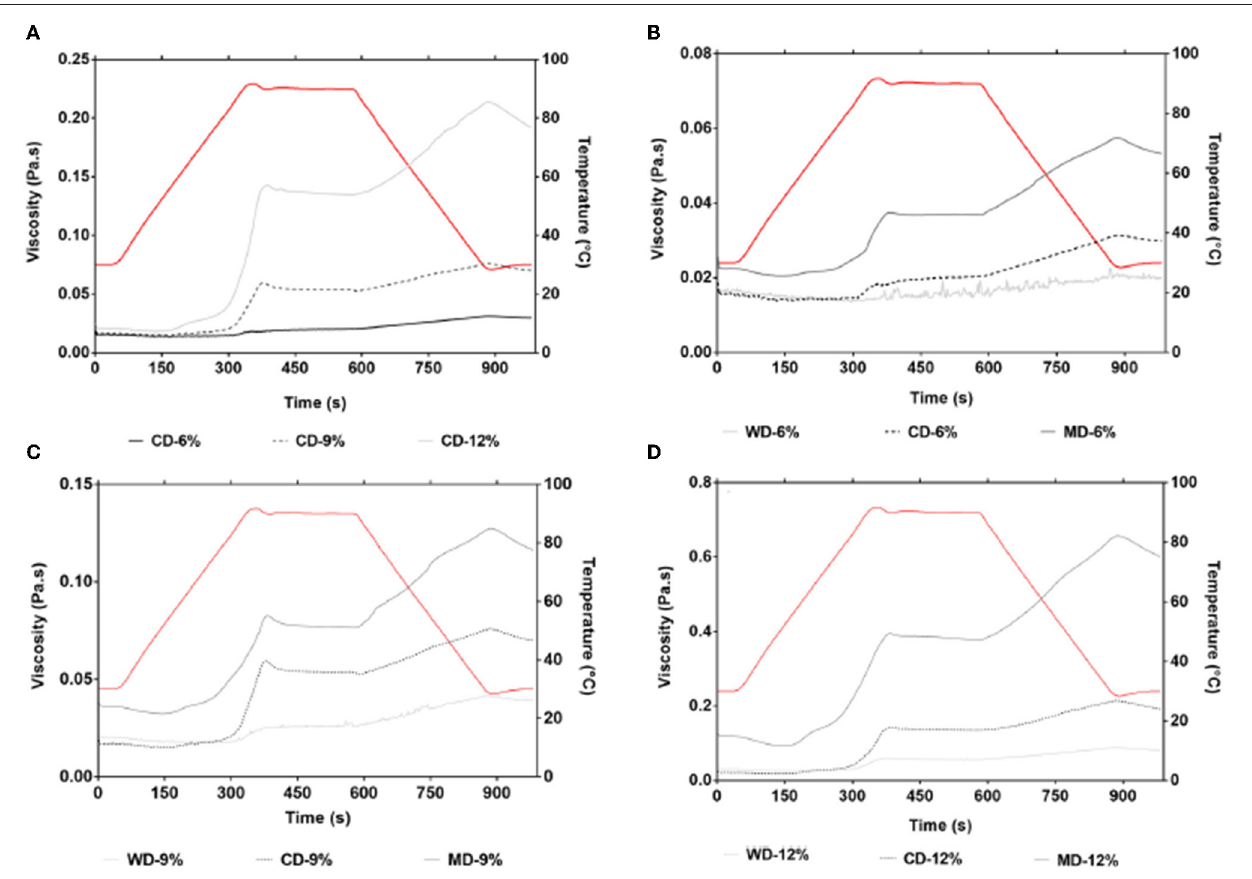
FIGURE 1 | Effect of concentration and defatting on the viscosity profiles of hyperprotein quinoa flour dispersions. Effect of chemical degreasing concentration on viscosity (A) . Dispersions with flour at concentrations 6% (B) , 9% (C) and 12% (D) of chemically defatted (CD), mechanically defatted (MD) and hyperprotein flour without defatting